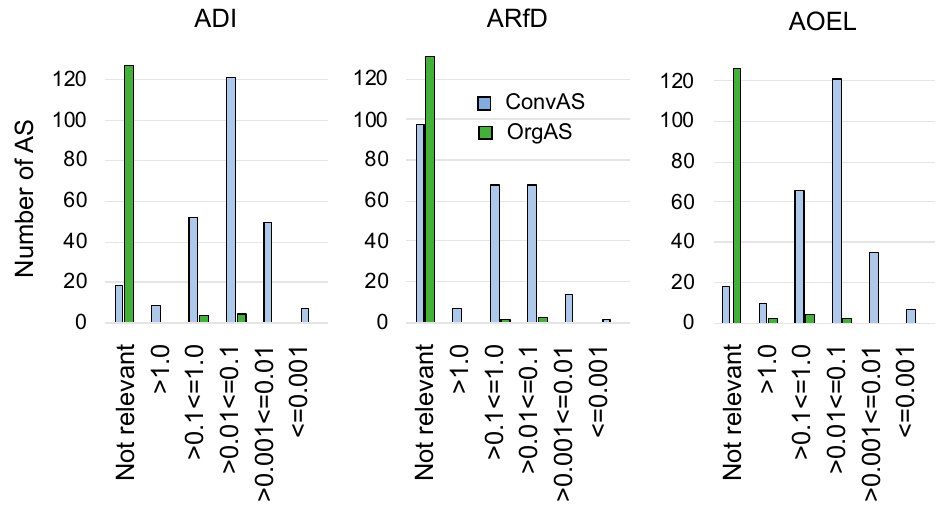
Figure 4. Comparison of ADI (Acceptable Daily Intake), ARfD (Acute Reference Dose), and AOEL (Acceptable Operator Exposure Level) of active substances (AS) approved for use in conventional (ConvAS, n = 256) and organic agriculture (OrgAS, n = 134).